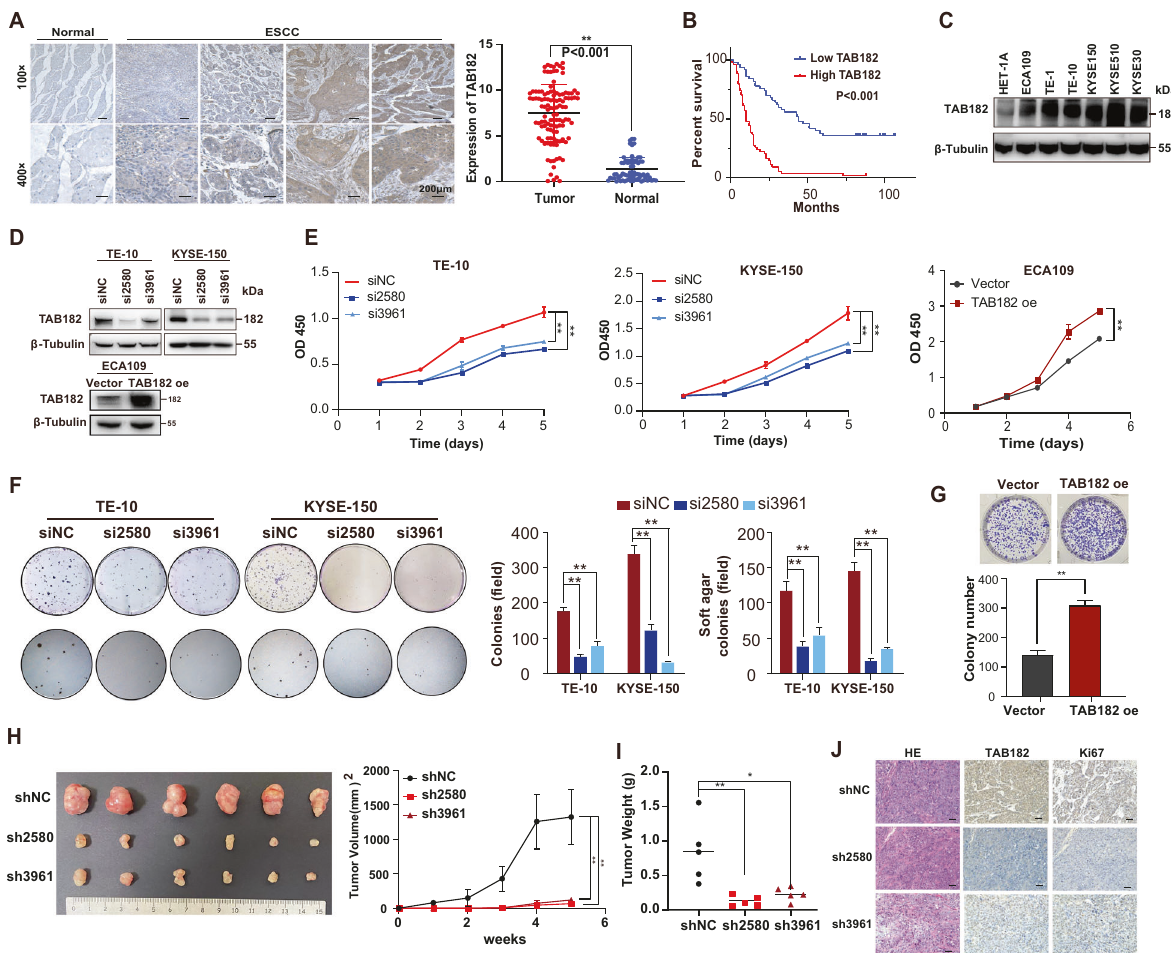
Fig. 1 TAB182 expression is up-regulated in ESCC and promotes tumorigenesis in vitro and in vivo. A the expression of TAB182 in human ESCC tissues was determined by immunohistochemical staining (105 cases), bar, 200 μ m. B the overexpression of TAB182 was closely associated with poor prognosis in ESCC patients. C Western blots results showed TAB182 expression levels in six ESCC cell lines and normal esophageal epithelial cells. D , protein levels of the TAB182 were detected by western blot in TAB182 knocked down and over-expressed ESCC cells 48 h post transfection. E Proliferation of TAB182 silenced and over-expressed cells was assessed by CCK8 assay 48 h post transfection. F soft agar and clonogenic assays were used to determine the clonogenic capacity of TE-10 and KYSE-150 cells 48 h post transfection. Clone numbers (>50 cells) in soft agar were determined after 2 weeks. G , clonogenic assay was performed to determine the colony formation ability of ECA109 cells. Clone numbers (>50 cells) were determined after 2 weeks. H subcutaneous xenograft tumors of the TAB182 silenced and control cells. xenograft tumors in mice followed up to 6 weeks. Data represented as mean ± SD ( n = 6 mice per group). I Tumor weights are represented as the mean tumor weight ± SD. J , tumors from mice were stained with H&E to visualize tumor morphology. TAB182 and Ki67 were detected by immunohistochemical staining. *, p < 0.05; **, p <